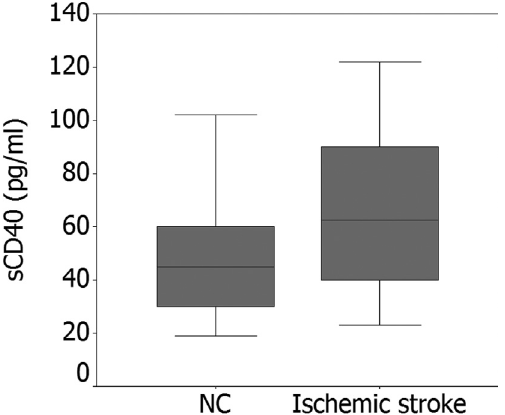
Figure 1 - The levels of sCD40 in patient with IS and the control group. Levels of sCD40 were higher in IS group than in the control group (61.3 (cid:2)